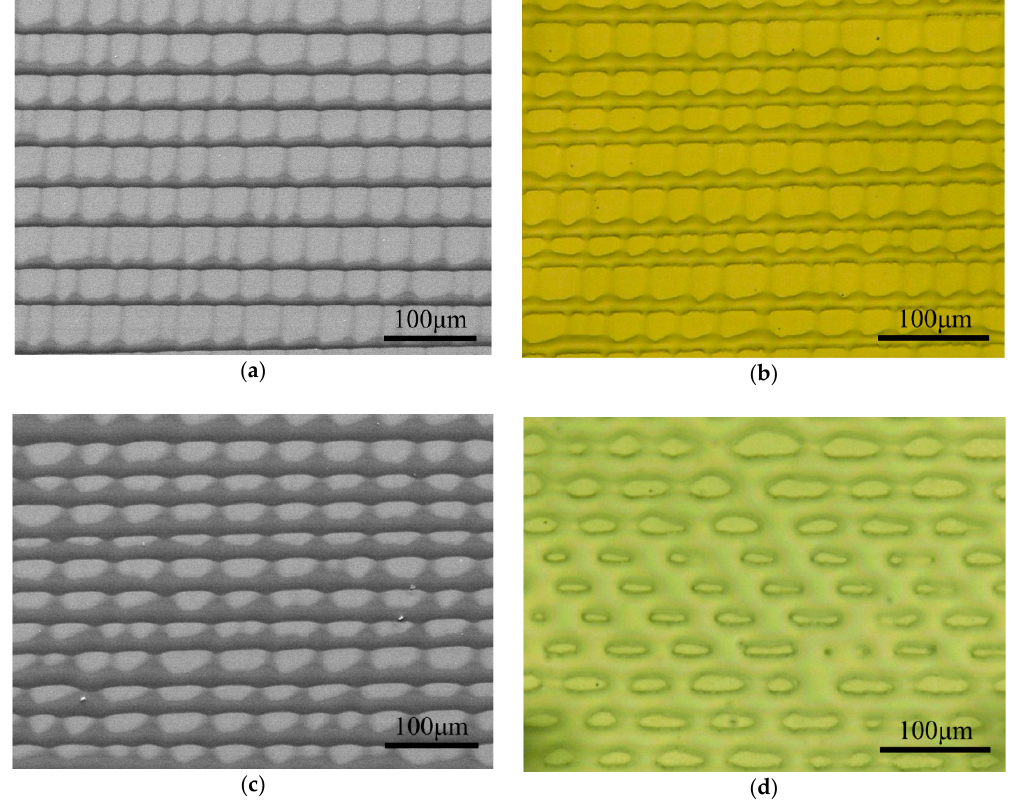
Figure 4. Morphologies of the PMMA microstructures. ( a , c ) SEM images of the as-prepared PMMA patterns obtained at varied gap heights of clearance; ( b , d ) optical microscope images of PMMA patterns after 200 °C annealing corresponding to ( a , c ), respectively.